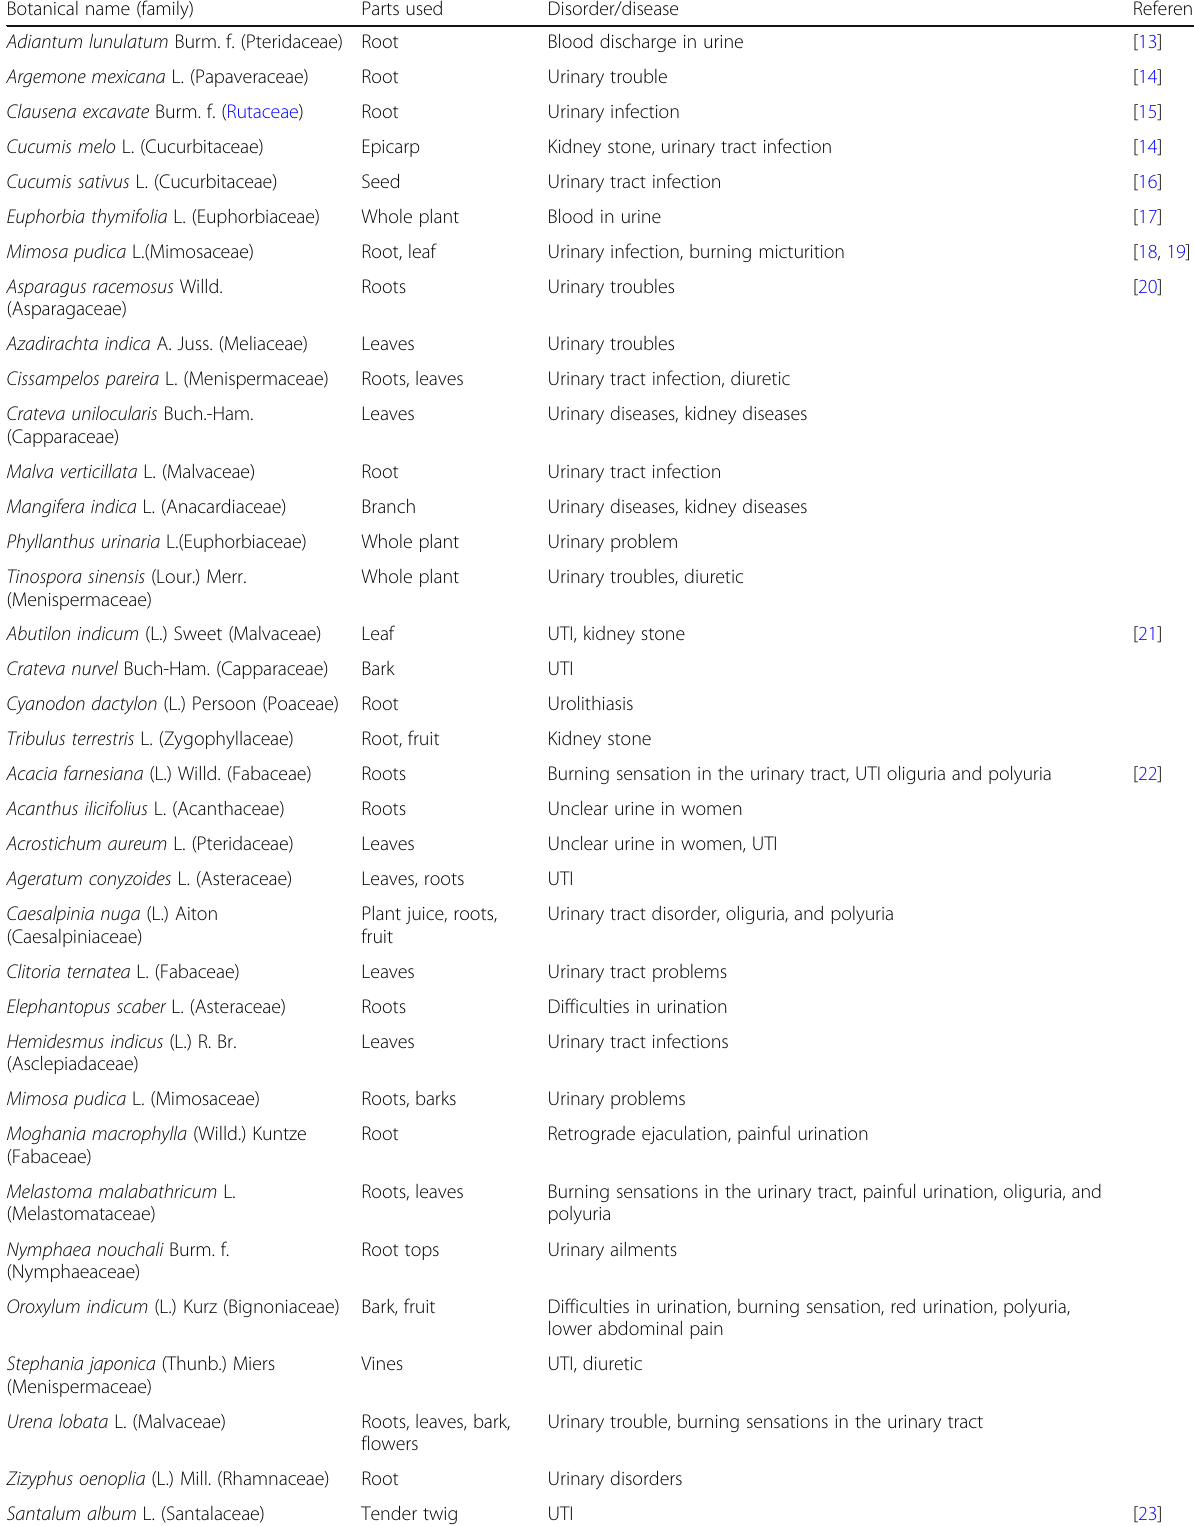
Table 1 Directory of some important ethnomedicinal plants/plant parts used for UTI Botanical name